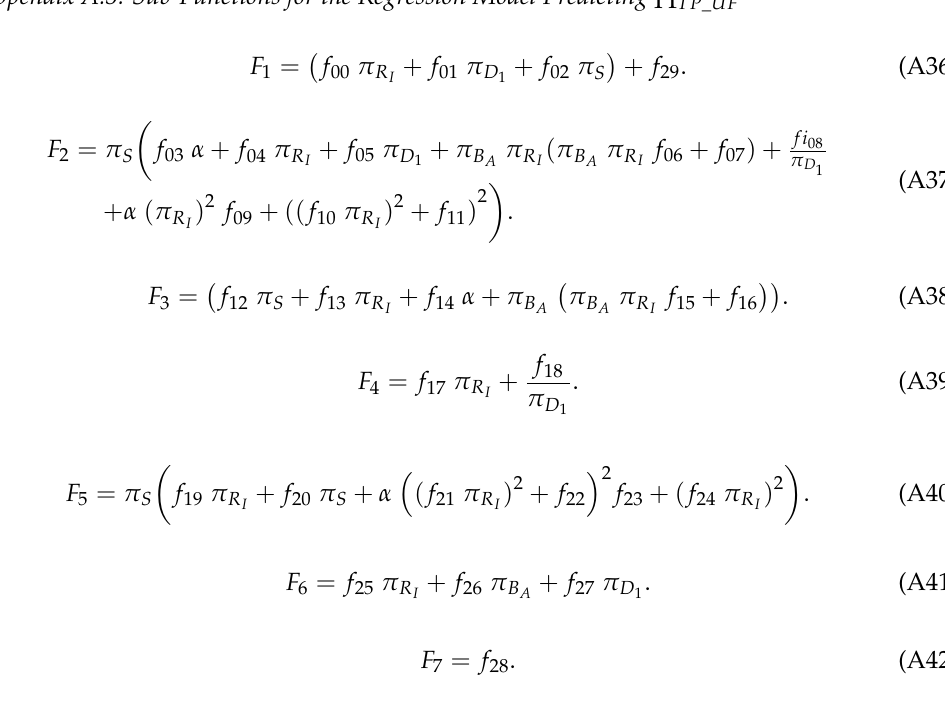
Table A5. Rounded values of the constant for Equation